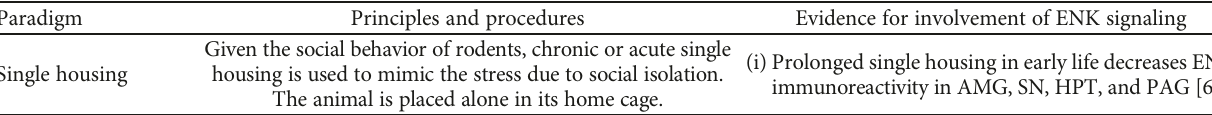
Table 2: Evidence for ENK signaling involvement under di ff erent stress paradigms.